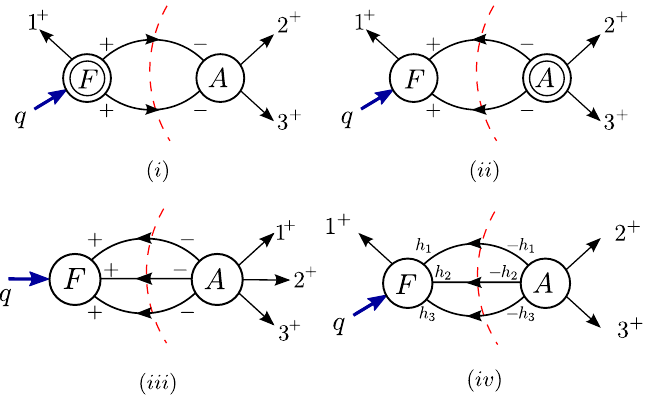
Figure 2 . Four di(cid:11)erent cuts of the two-loop form factors which will be used to construct the two-loop integrand.